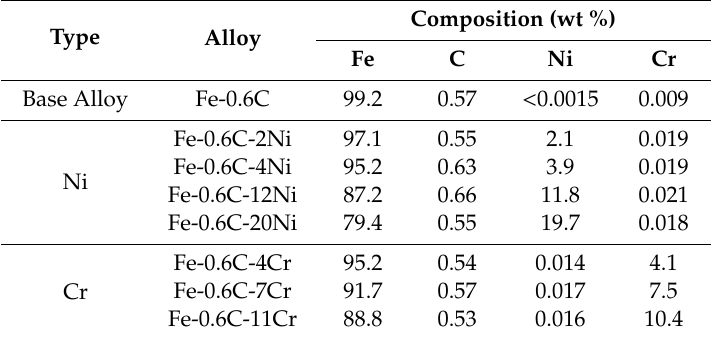
Table 1. Chemical Composition Determined Using a SPECTROMAXx Stationary Metal Analyzer (SPECTRO Analytical Instruments GmbH, Kleve, Germany) in Weight Percent of the Cast Model Alloys.